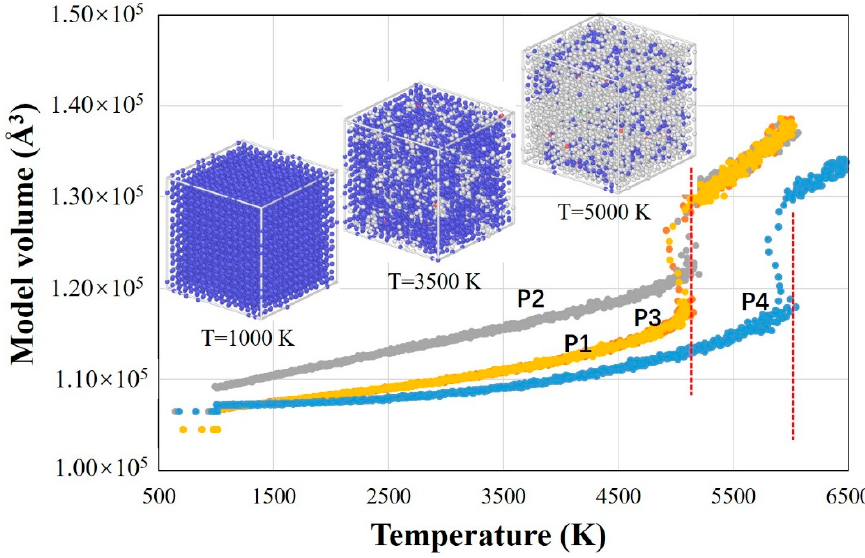
Figure 2. Model volume as a function of temperature simulated by four interatomic potentials. The inserted images are the atomic configuration of the model at different temperatures by P2. Atoms are colored by CNA method, where the blue atoms are in BCC structure, and the white atoms are in disordered structure.